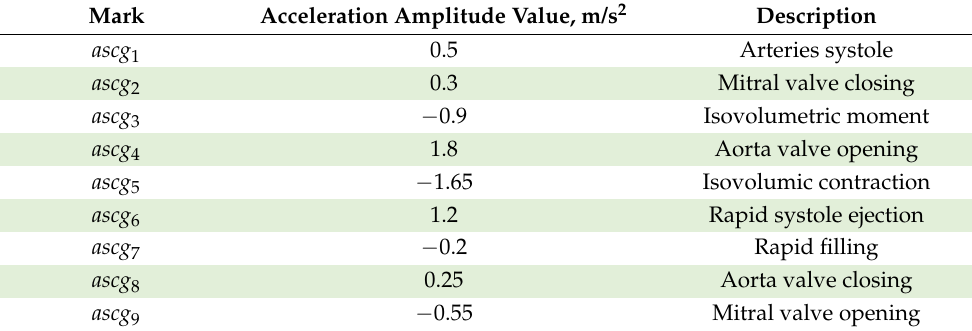
Table 2. Modeled SCG signal acceleration amplitude values and description. Mark Acceleration Amplitude Value, m/s 2